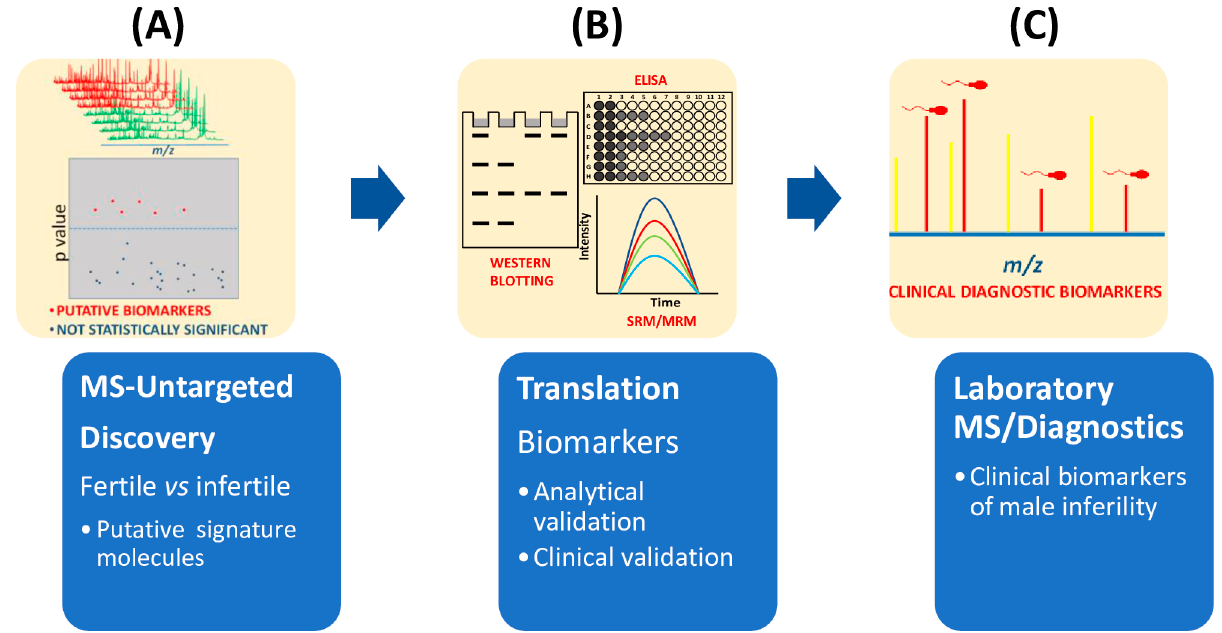
Figure 3. Flow chart of main steps required in clinical proteomics to select biomarkers of male infertility. ( A ) Untargeted MS-based proteomics approaches compare seminal plasma from fertile and infertile men. Mass data analysis, for example by multivariate statistical analysis, is used to extract the differences among mass spectra. ( B ) Potential biomarkers are then validated by different methodologies (immunohistochemistry, ELISA, immunoblotting) or mass spectrometry approaches such as SRM or MRM. ( C ) Before being approved as clinical biomarkers of infertility, clinical validation is also